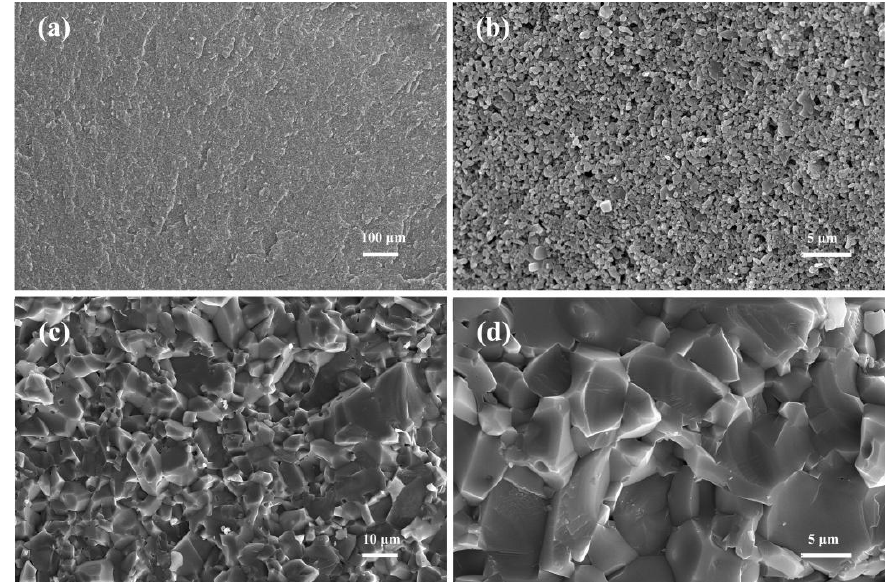
Fig. 8 SEM micrographs of the fractured surfaces of the printed Al 2 O 3 samples: (a, b) the green body and (c, d) the sintered